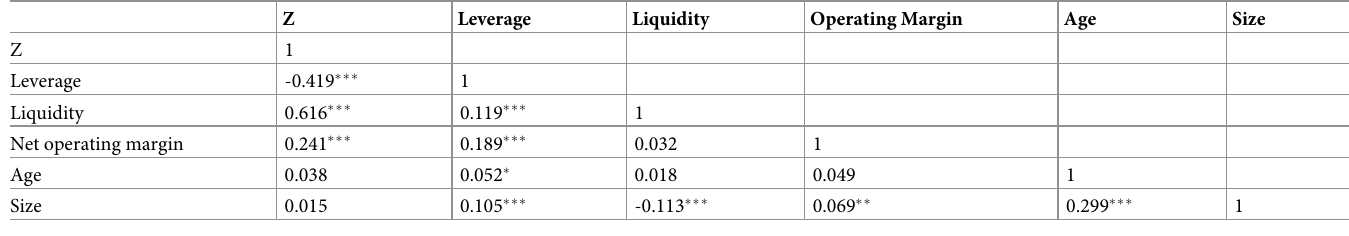
Table 3. Summary of Pearson’s